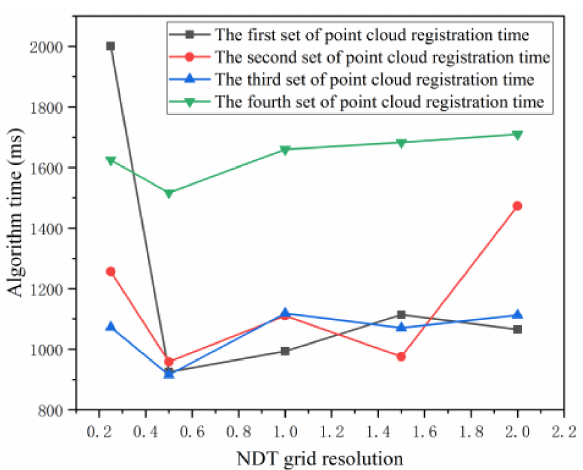
Figure 9. NDT registering results.